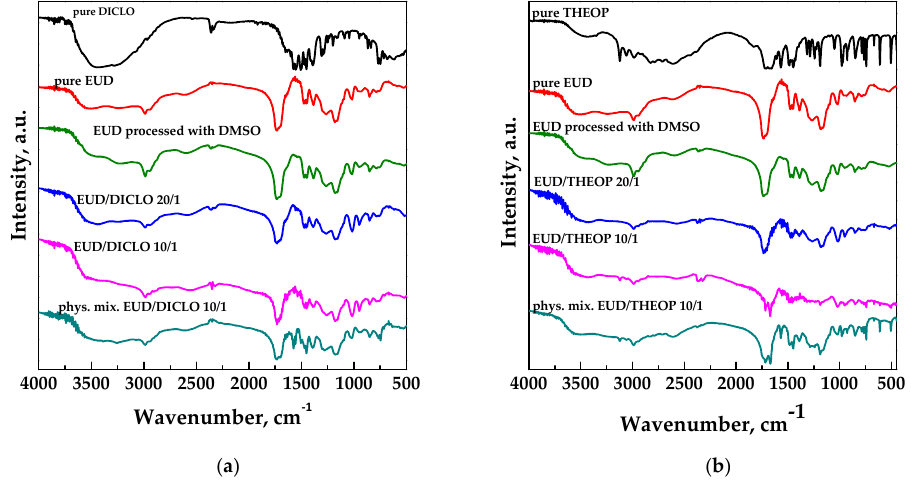
Figure 11. FT-IR spectra for unprocessed and SAS processed Eudragit L100-55, unprocessed drugs, physical mixture polymer/drug and SAS processed Eudragit/drug powders. ( a ) DICLO; ( b ) THEOP. FT-IR spectra of pure and unprocessed EUD is characterized by absorption bands at around 1157 cm − 1 , 1184 cm − 1 e 1261 cm − 1 , corresponding to the ester vibrations, peaks at about 1701 cm − 1 and at 1736 cm − 1 attributed to the C = O stretching of the carboxylic acid and the vibrations of the esterified carboxyl groups, respectively; moreover, the presence of peaks at 1387 cm − 1 , 1479 cm − 1 e 2979 cm − 1 corresponded to CHX vibrations [29]. No changes were observed in the polymer at the level of the functional group after SAS processing. FT-IR spectra of the physical mixture and SAS processed EUD/DICLO powders clearly showed the characteristic bands of the polymer, since it is present in more quantity, and few peaks related to DICLO as the C–Cl stretching at about 720 cm − 1 [38]. In addition to EUD characteristic peaks, FT-IR spectra of physical mixture and SAS processed EUD/THEOP powders exhibited several absorption bands attributed to the theophylline, such as at 3120 cm − 1 assigned to the N–H stretching, at 3060 and 2989 cm − 1 related to the C–H stretching, at about 1718 and 1667 cm − 1 assigned to the carbonyl stretching and at 1307 cm − 1 assigned to the C–O stretching [39–41]. DSC thermograms of the unprocessed drug, unprocessed and processed EUD and SAS processed EUD/drug 20/1 and 10/1 w / w are reported in Figure 12a,b for DICLO and THEOP, respectively.